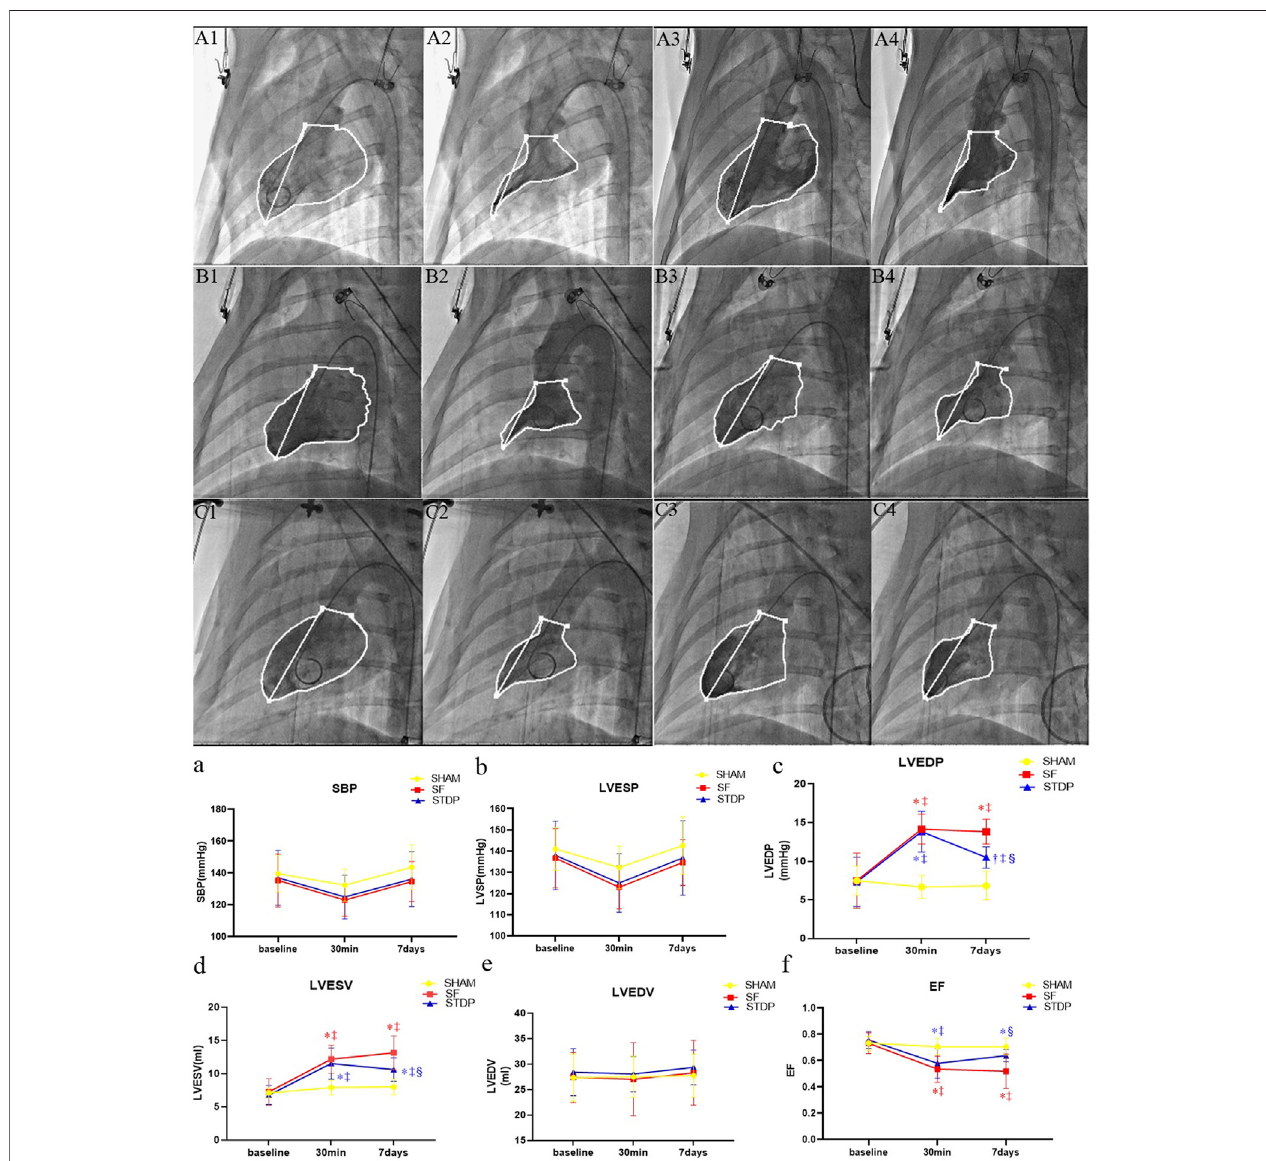
FIGURE 4 | Hemodynamic parameters and cardiac function parameters at baseline, 30 min, and 7 days post LAD coronary microsphere injection. (A – C) : Left ventricular angiography baseline and 7 days after embolization in each group. (A1,A2) : Preoperative diastolic to systolic volume in the SHAM group. (A3,A4) : Postoperative 7 days diastolic to systolic volume in the SHAM group. (B1,B2) : Preoperative diastolic to systolic volume in the SF group. (B3,B4) : Postoperative 7 days diastolictosystolicvolumeintheSFgroup. (C1,C2) :PreoperativediastolictosystolicvolumeintheSTDPgroup. (C3,C4) :Postoperative7 daysdiastolictosystolic volume in the STDP group The activity of porcine myocardium decreased signi fi cantly after injection, and abnormal movement occurred during systole in the SF group 7 days after embolization. (a – f) : Line chart of hemodynamic parameters and cardiac function parameters at baseline, 30 min, and 7 days post LAD coronary microsphere injection. SBP, systolic pressure; LVESP, left ventricular end-systolic pressure; LVEDP, left ventricular end-dystolic pressure; LVESV, left ventricular end- systolic volume; LVEDV, left ventricular end-diastolic volume; LVEF, left ventricular ejection fraction. Data are presented as the mean ± SD. p < 0.05 *vs. baseline, † vs. 30 min, ‡ vs. Sham group, and §vs. SF group ( n = 6 for each group).